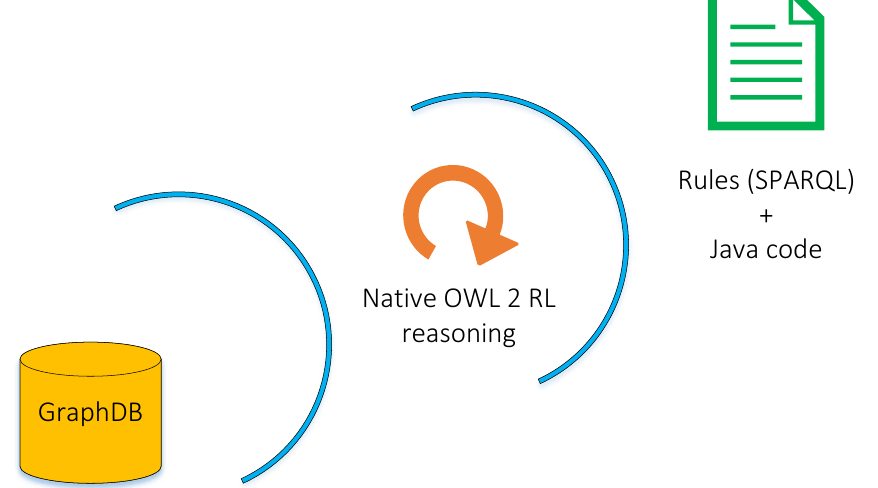
Figure 6. Abstract reasoning